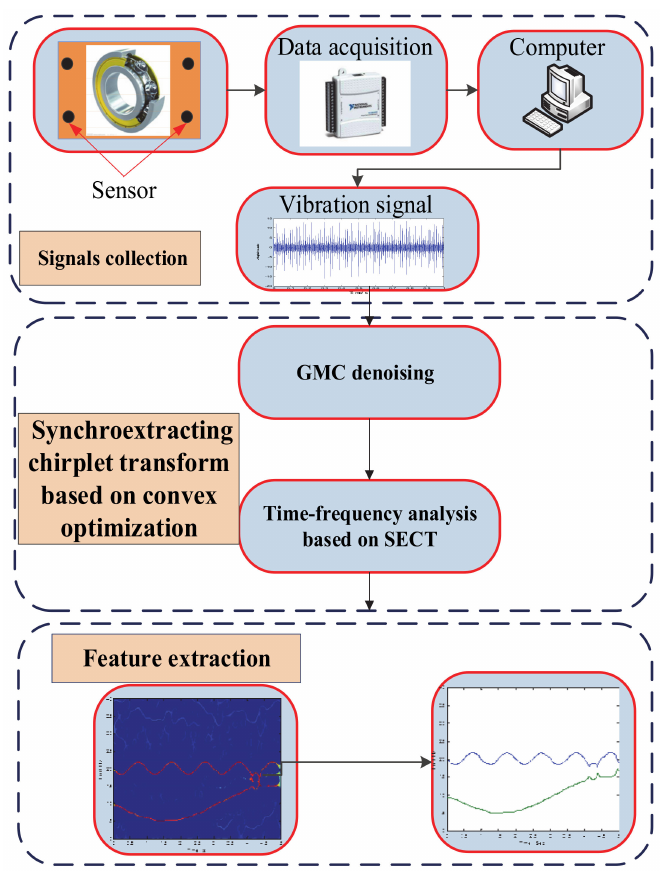
Figure 1. The flowchart of the proposed